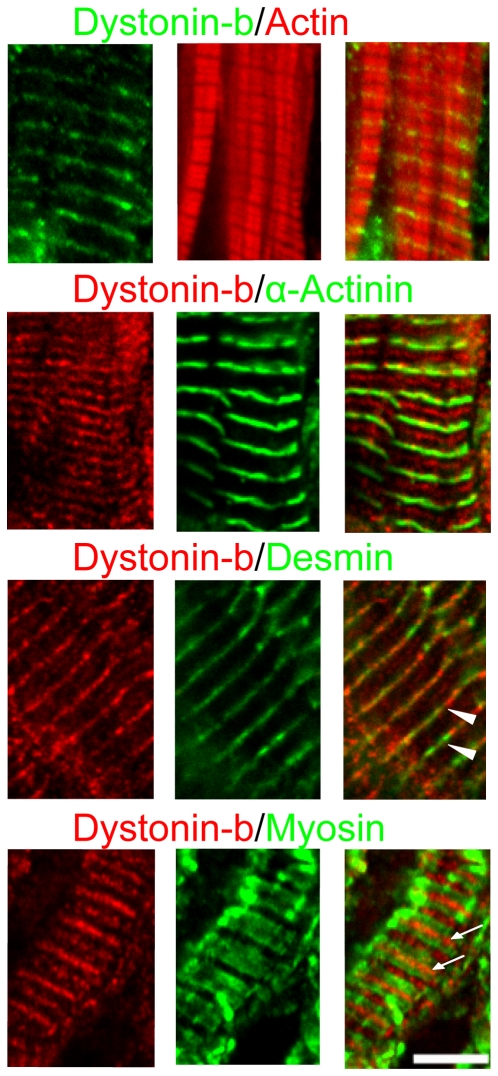
Sarcomeric localization of dystonin-b in cardiac muscle tissue.Longitudinal wild-type cardiac muscle tissue sections were stained with the dystonin-b antibody and other sarcomeric proteins as indicated. The dystonin-b antibody localizes at Z-discs (arrow heads) and at the H zone (arrows). Dystonin-b does not co-distribute with actin or myosin. Scale bar  = 5 µm for all images.